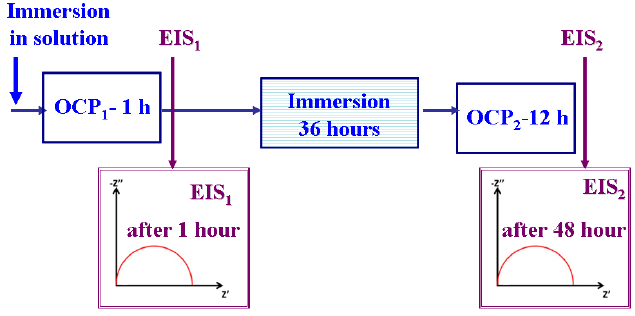
Figure 11. Schematic representation of the experimental